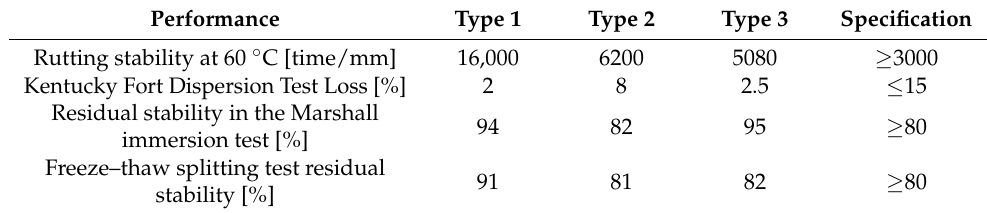
Table 4. Performance of the three VTAO mixtures.